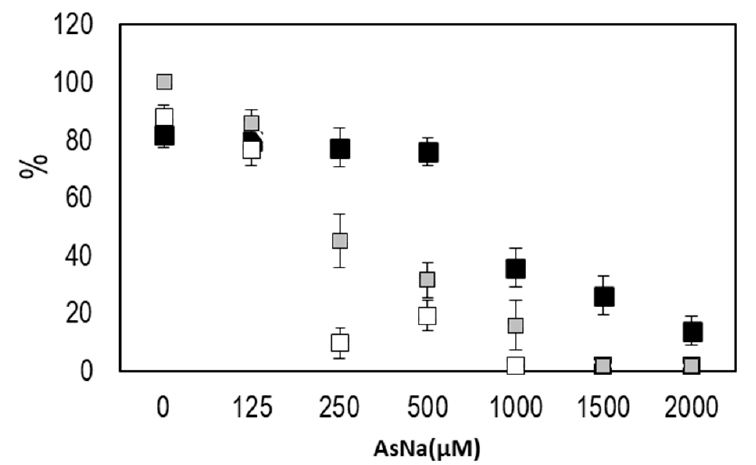
Figure 2. J. montana planted on different concentration of arsenate. Percentage of germination (black